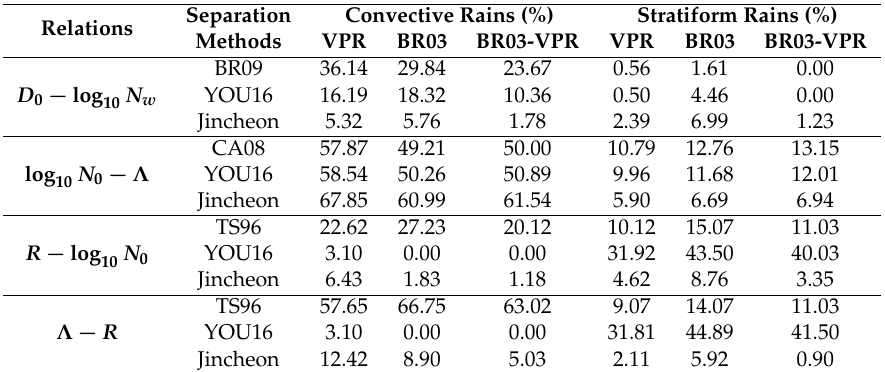
Table 3. Percentages of the misclassification of stratiform and convective rains based on the relations